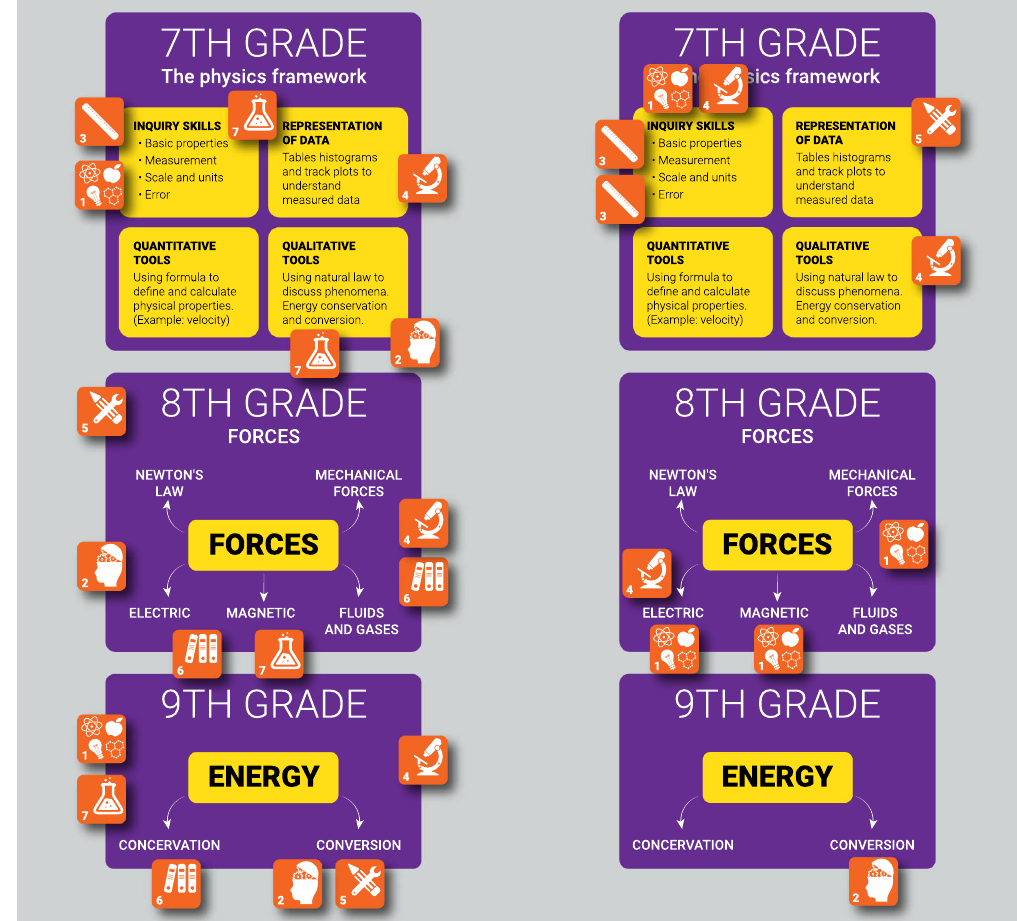
FIG. 2. The interview board at the end of the exercise. Boards of two different experts for each icon signify a connection made and explained by the expert, presenting an overall picture of one participant ’ s point of